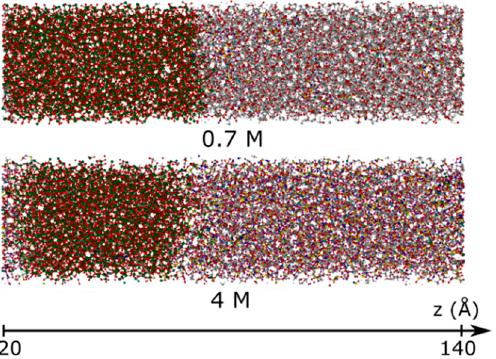
Figure 4. Screenshots of the model battery systems with 0.7 and 4 M LiTFSI concentrations within the electrolyte. In addition, the z -coordinate axis used for the subsequent evaluations is introduced.